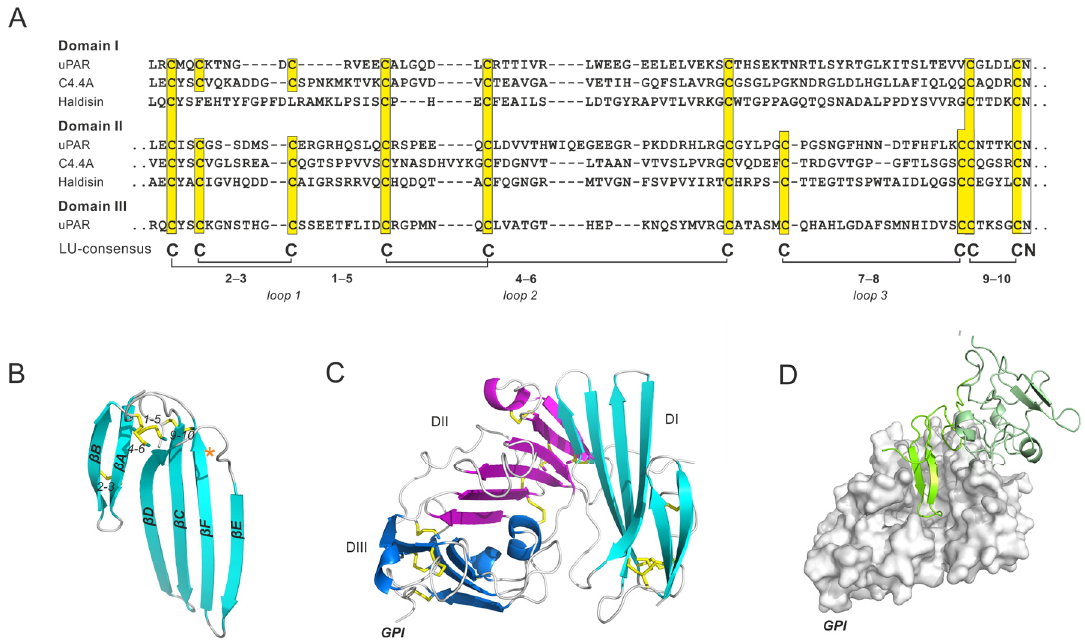
Figure 5. Multi-LU-domain proteins. ( A ) A sequence alignment of three human multi-LU-domain proteins: uPAR / PLAUR (Uniprot: Q03405), C4.4A / LYPD3 (Uniprot: O95274) and Haldisin / LYPD5 (Unitprot: Q6UWN5). This alignment includes the first two LU domains in uPAR, C4.4A and Haldisin, along with third LU domain in uPAR. Note, that the plesiotypic 7 − 8 disulfide bond is lacking in all the N-terminal LU domains. ( B ) Cartoon representation showing that the structure of the N-terminal LU domain of uPAR with the position of the missing 7 − 8 disulfide highlighted by an asterisk. Disulfide bonds are shown as yellow sticks. ( C ) Cartoon representation illustrating the assembly of the three LU domains in intact uPAR, with DI in cyan, DII in purple, and DIII in blue. The position of the glycolipid-anchor that tethers uPAR to the cell membrane is shown (GPI). ( D ) The complex between uPAR (gray surface representation) and the amino-terminal fragment (ATF) of its primary high-a ffi nity ligand uPA (shown in a green cartoon representation). The structures were created by PyMol with the PDB coordinates 3BT1